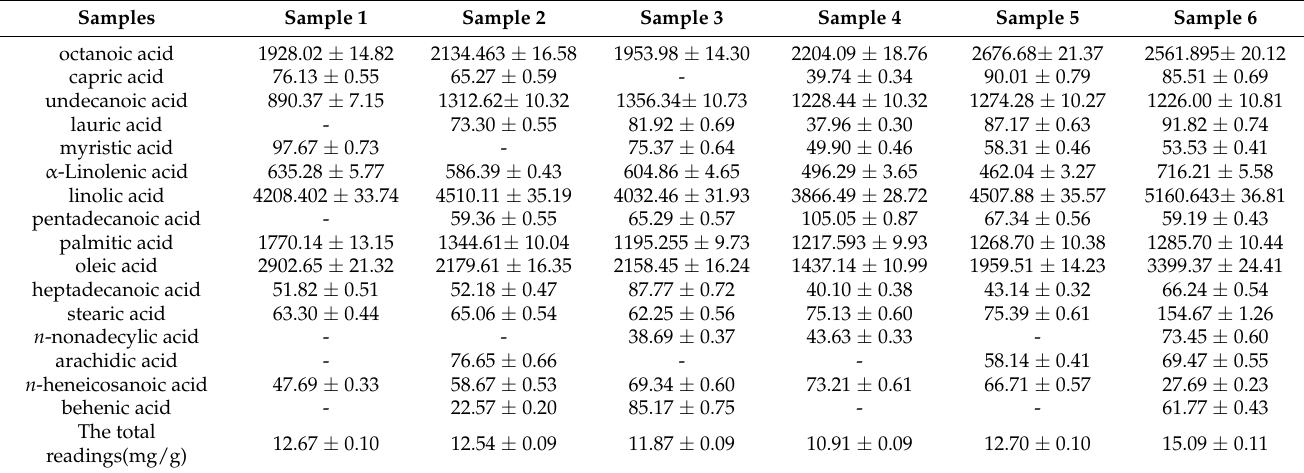
Table 9. The contents of fatty acids from Potentilla anserina L. by MAE ( µ g/g, n =